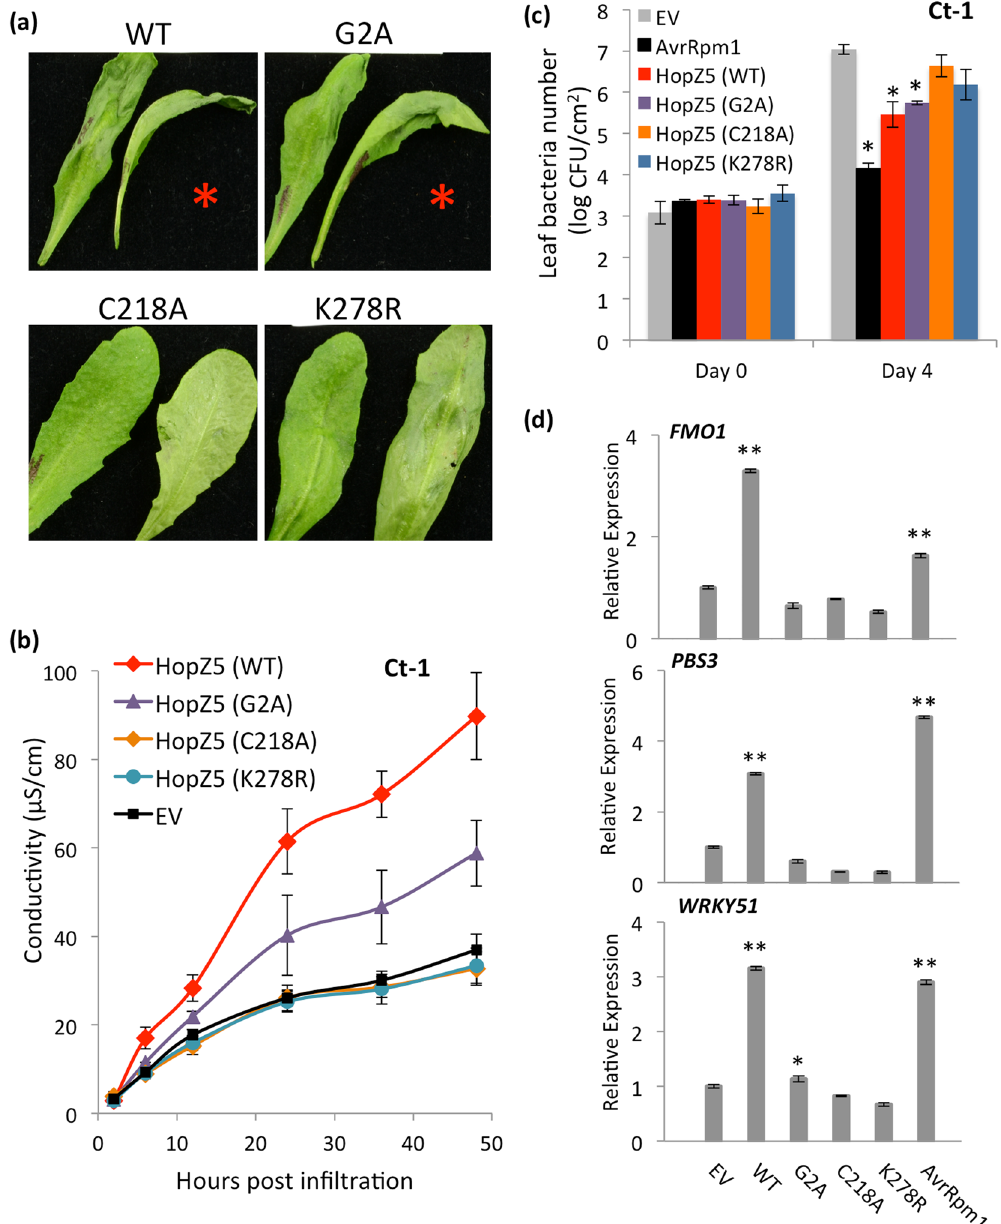
Figure 4. Putative acetyltransferase activity and myristoylation of HopZ5 are required for avirulence. ( a ) Development of the hypersensitive response in the Arabidopsis accession Ct-1 against HopZ5 variants. P . fluorescens Pf0-1 (T3S) (1 × 10 8 CFU/mL) carrying hopZ5 - HA (WT), hopZ5 (G2A)- HA , hopZ5 (C218A)- HA or hopZ5 (K278R)- HA was blunt syringe-infiltrated into leaves and photographs taken 20 hours after infiltration. The red asterisk indicates development of the hypersensitive response. ( b ) Electrolyte leakage from Arabidopsis accession Ct-1 leaf discs after infiltration with P . fluorescens Pf0-1 (T3S) expressing HopZ5 variants, as in ( a ). Bacteria (1 × 10 8 CFU/mL) were blunt syringe-infiltrated into the leaves. The error bars indicate the standard error from four technical replicates. The experiment was conducted five times with similar results. ( c ) Pto DC3000 growth in Arabidopsis accession Ct-1. Pto DC3000 carrying hopZ5 variants, as in ( a ), was blunt syringe-infiltrated at 5 × 10 5 CFU/mL into Arabidopsis leaves, and bacterial growth was determined 4 days post-infection (4 dpi). Error bars represent standard error from six technical replicates. Asterisks indicate results of Student’s t -test between selected sample and EV for that accession; * ( P < 0.05), ** ( P < 0.01). The experiment was conducted nine times with similar results. ( d ) Defence gene expression in Arabidopsis Ct-1 in response to HopZ5 variants, as in ( a ). P . fluorescens Pf0-1 (T3S) (1 × 10 8 CFU/mL) carrying the indicated construct was blunt syringe-infiltrated into leaves and defence gene expression determined from extracted RNA by quantitative polymerase chain reaction. Expression for each defence gene is relative to internal EF1 α expression and defence gene expression for EV samples indicated. Error bars indicate standard error from three technical replicates. Asterisks indicate results of Student’s t-test between selected sample and EV for that accession; * ( P < 0.05), ** ( P < 0.01). The experiment was conducted five times with similar